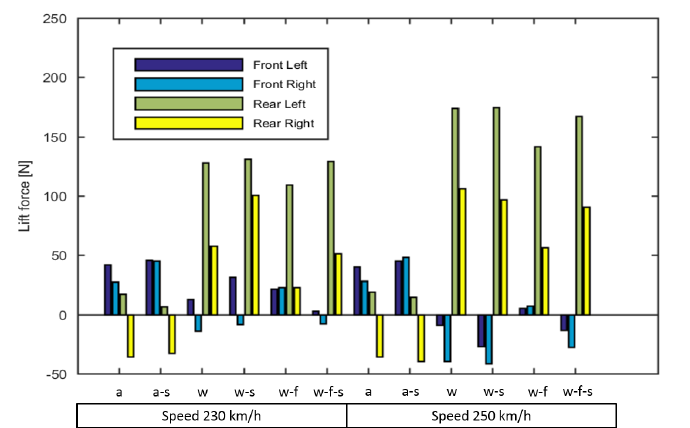
Figure 7. RMS of relative suspension displacement for different configurations and speeds.